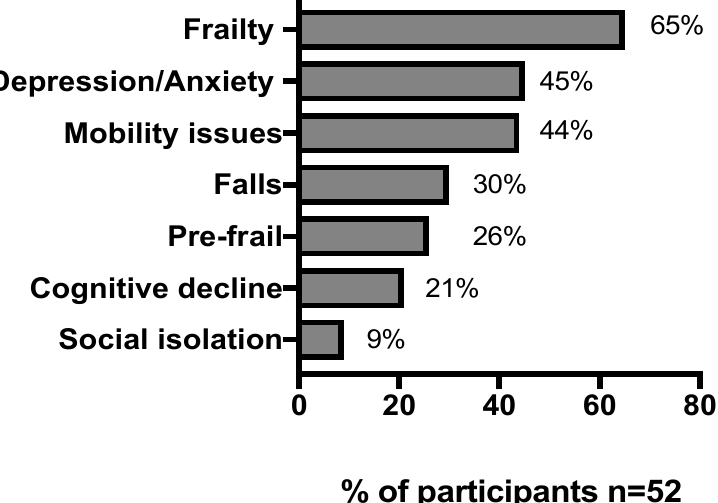
Figure 2. Frequencies of geriatric syndromes.